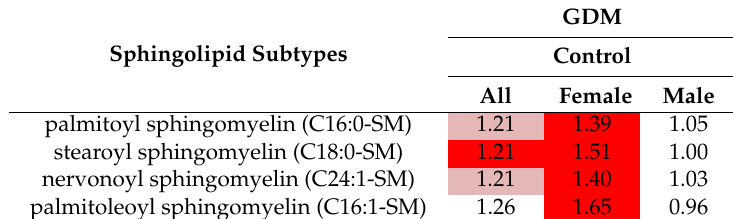
GDM Control All